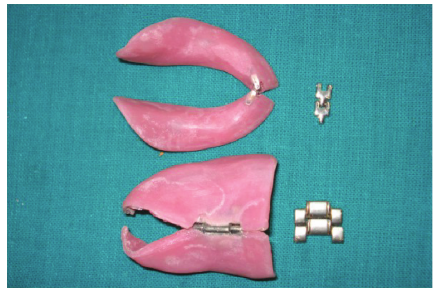
Figure 4: Temporary denture base with